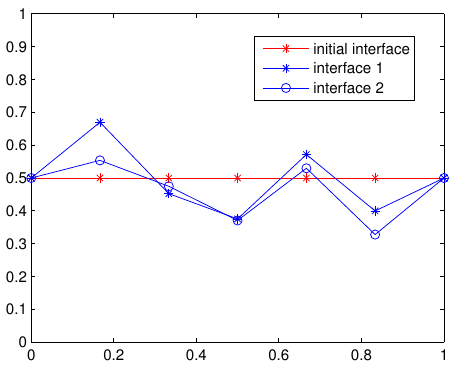
Figure 3. Interface updates using velocity representation at some fixed